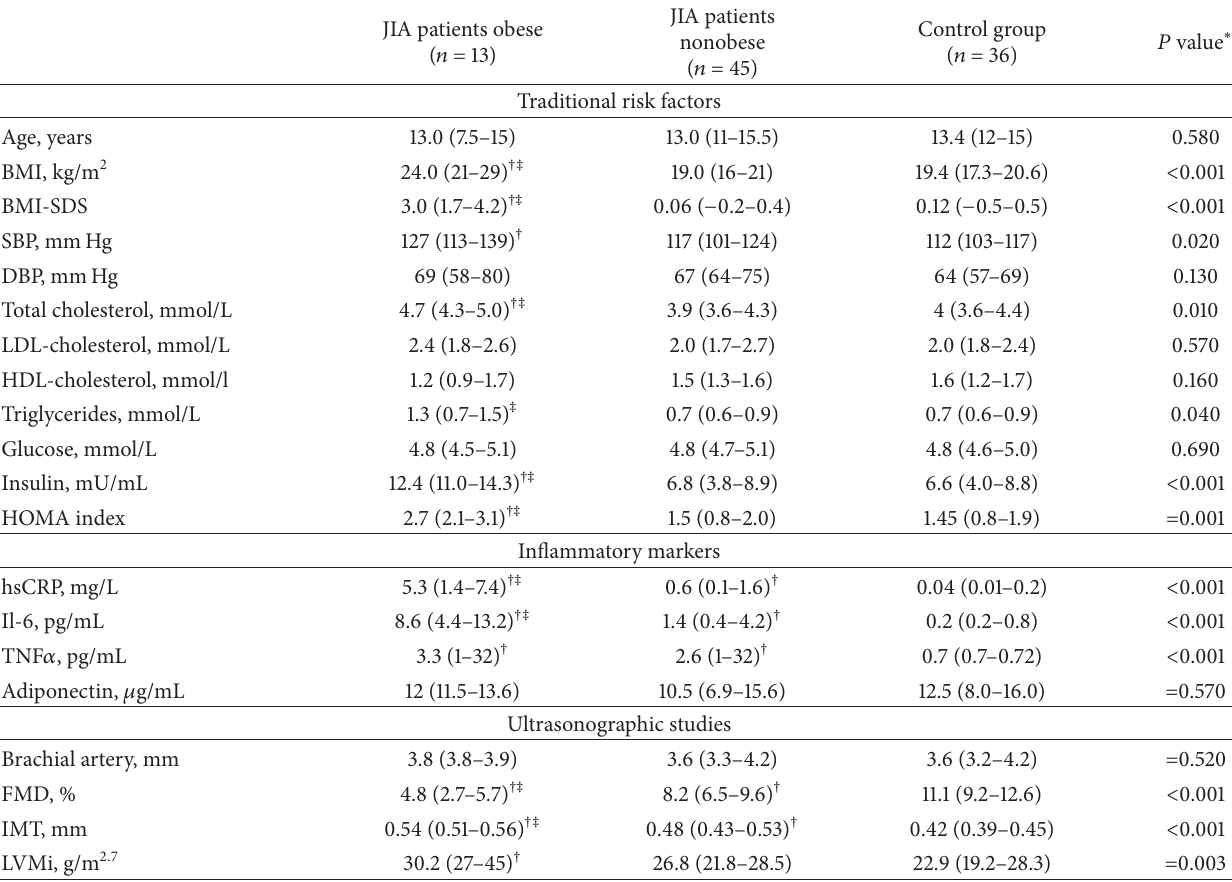
Table 3: Traditional cardiovascular risk factors, selected inflammatory markers, and ultrasonographic evaluation of cardiovascular system in nonobese and obese juvenile idiopathic arthritis (JIA)